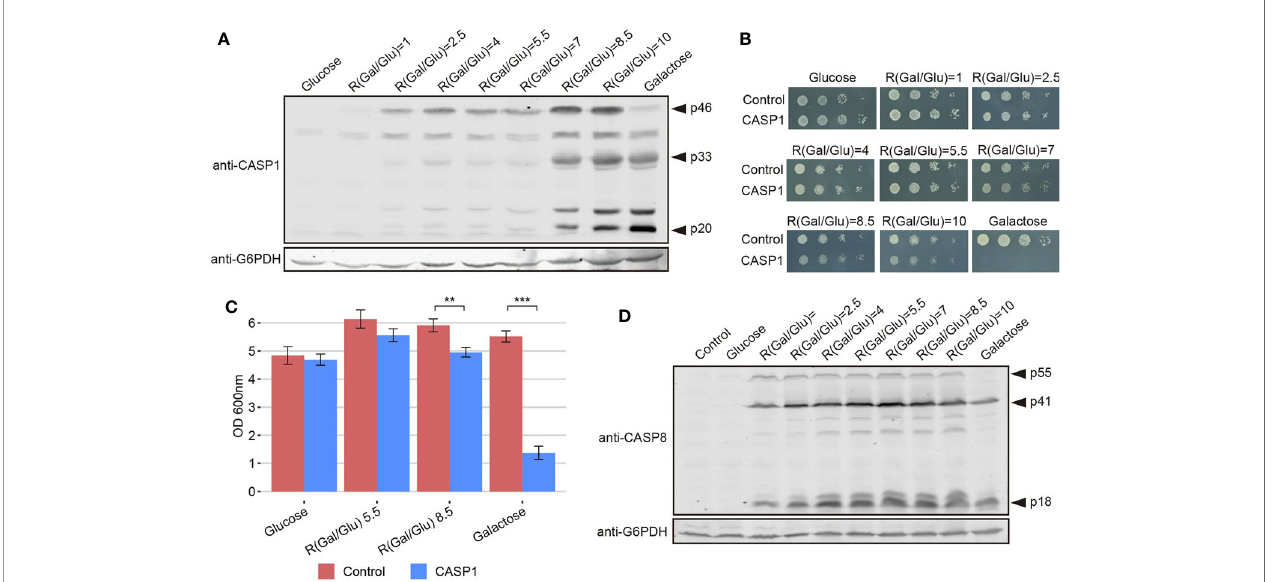
FIGURE 6 | The modulation of caspase-1 expression, but not of caspase-8, under the GAL1 promoter limits its auto-processing and toxicity. (A) Immunoblot showing the expression of caspase-1 in yeast lysates of BY4741 strain bearing pAG413-caspase-1. Cells were cultured in synthetic media containing the indicated Gal/Glu ratios with a fi nal concentration of sugars of 2% for 5 h. Cells cultured in SD medium were used as a negative control of expression and cells cultured in SG media as a positive control. Membrane was hybridized with anti-caspase-1 antibody. Anti-G6PDH antibody was used as a loading control. A representative assay from two different experiments with distinct transformants is shown. (B) Spot growth assay performed with the same strain and the same ratios of galactose/glucose as in panel (A) , but in solid media. Cells bearing pAG413 empty plasmid were used as growth control. A representative assay from three different experiments with distinct transformants is shown. (C) Measurement of OD 600 after 24 h of incubation in media containing a R(Gal/Glu) = 5.5 and R(Gal/Glu) = 8.5 of BY4741 strain bearing either pAG413-caspase-1 or the pAG13 empty plasmid as growth control. As in panel (B) , cells cultured in SD medium were used as a negative control of expression, and cells cultured in SG media as a positive control of expression. Results correspond to the mean of three biological replicates performed on different transformants. Error bars represent SD. Asterisks (**, ***) indicate a p-value < 0.01 and 0.001, respectively, by the Student ’ s T-test. (D) Immunoblotting performed as in panel (A) but with BY4741 strain bearing pAG413-caspase-8 or the pAG413 empty plasmid as control. Membrane was hybridized with anti – caspase-8 antibody. Anti-G6PDH antibody was used as a loading control. A representative assay from two different experiments with different transformants is